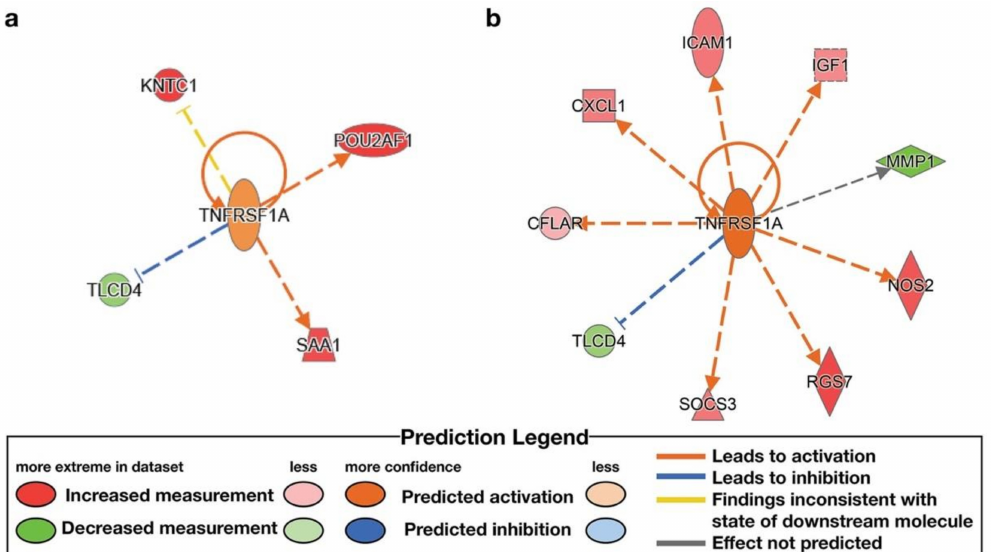
Figure 8. Differentially expressed genes (FDR adjusted p -value < 0.05) contributing to the identifi- cation of upstream regulator, TNF superfamily receptor 1A (TNFRSF1A) following lignan flaxseed intervention: ( a ) no statistically significant effect in high-ENL excreters (z-score 1.091); ( b ) predicted activation of TNFSF1A in low-ENL excreters (z-score